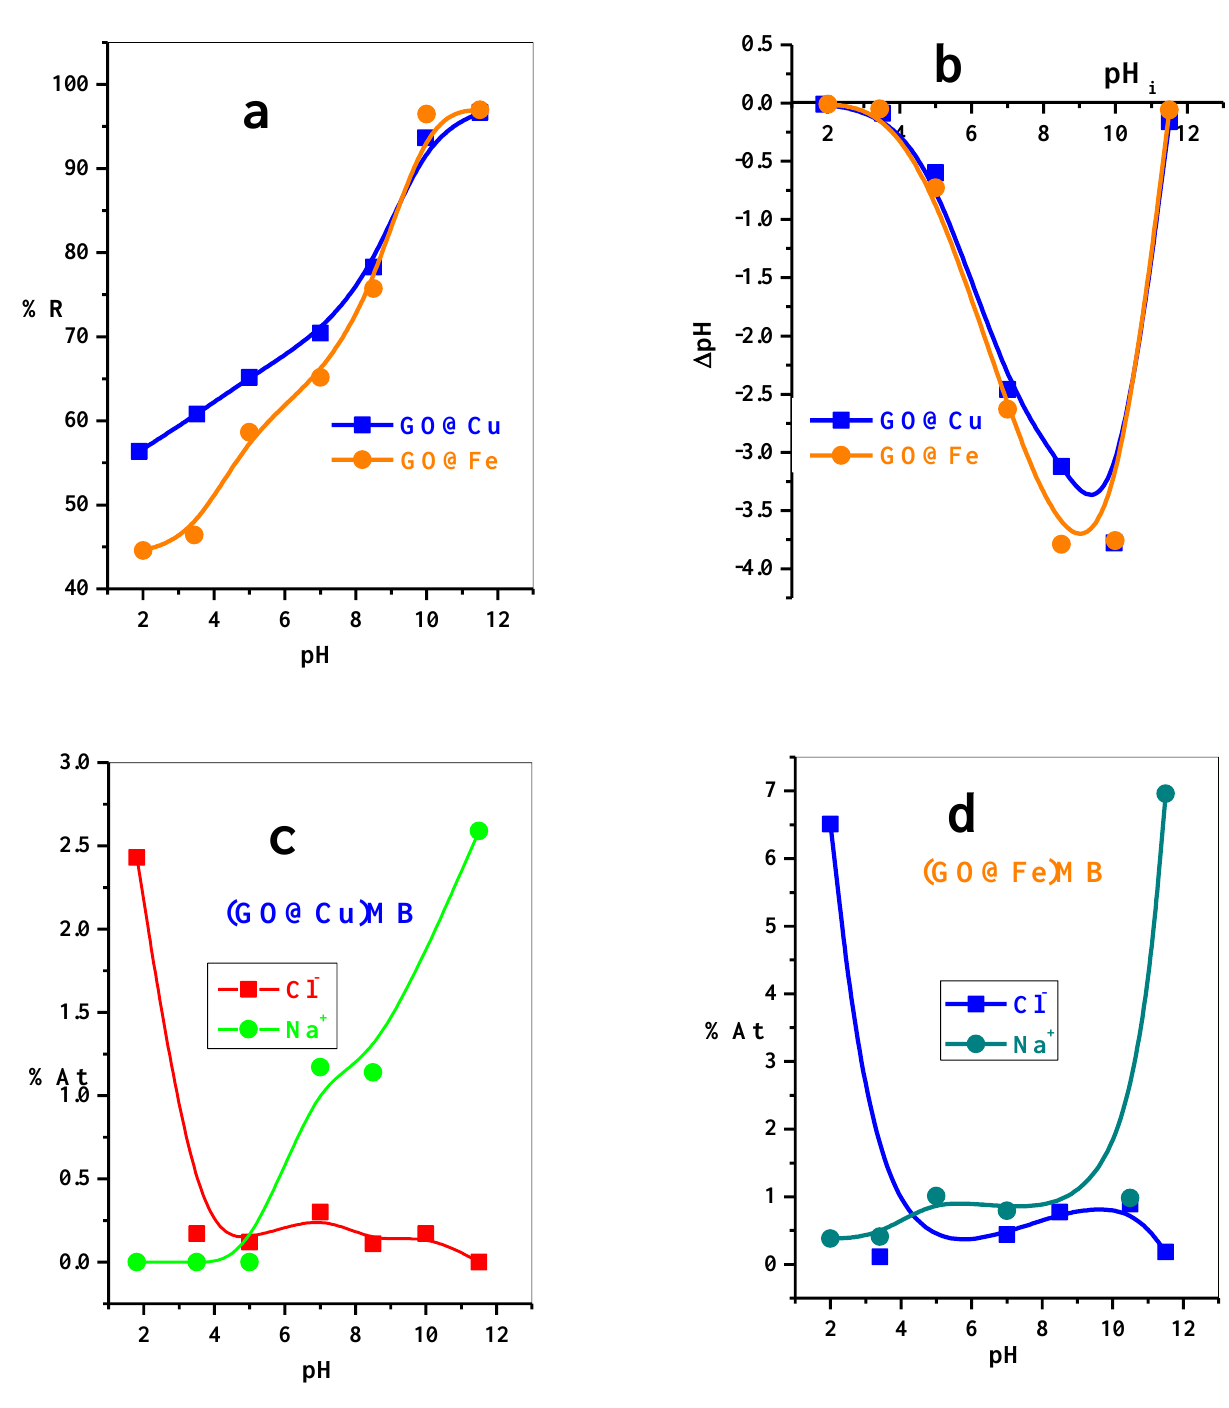
Figure 8. Effect of the initial solution pH on the ( a ) removal percentage (% R) from aqueous solution, ( b ) pH ZPC of the GO-M, M = Cu 2+ or Fe 3+ , adsorbent of MB-dye; GO-Cu (t = 2.5 min, [MB] = 50 mg L − 1 , dose = 5 mg, V = 50 mL, T = 25 ◦ C) and GO-Fe (t = 2.5 min, [MB] = 30 mg L − 1 , dose = 6 mg, V = 50 mL, T = 25 ◦ C) and ( c , d ) the %At of Cl − and Na + ions on the GO-M surface at different pH environment. The GO-sheet is completely loaded with the M-ion species. Moreover, the speciation of these M-ions alters according to pH ranges. Where, at low pH values, the M-ion will be presented in the cation form (M z+ ) with further increase in the pH, it will work for hydrox- ide complex M(OH) 2 ; consequently, a higher hydroxide complex M(OH) 4 will be formed at higher pH values. In this study, the electronegativity of the composites (GO@Cu and GO@Fe) were tracked in different pH environments (Figure 8b). At low pH values (1.9),